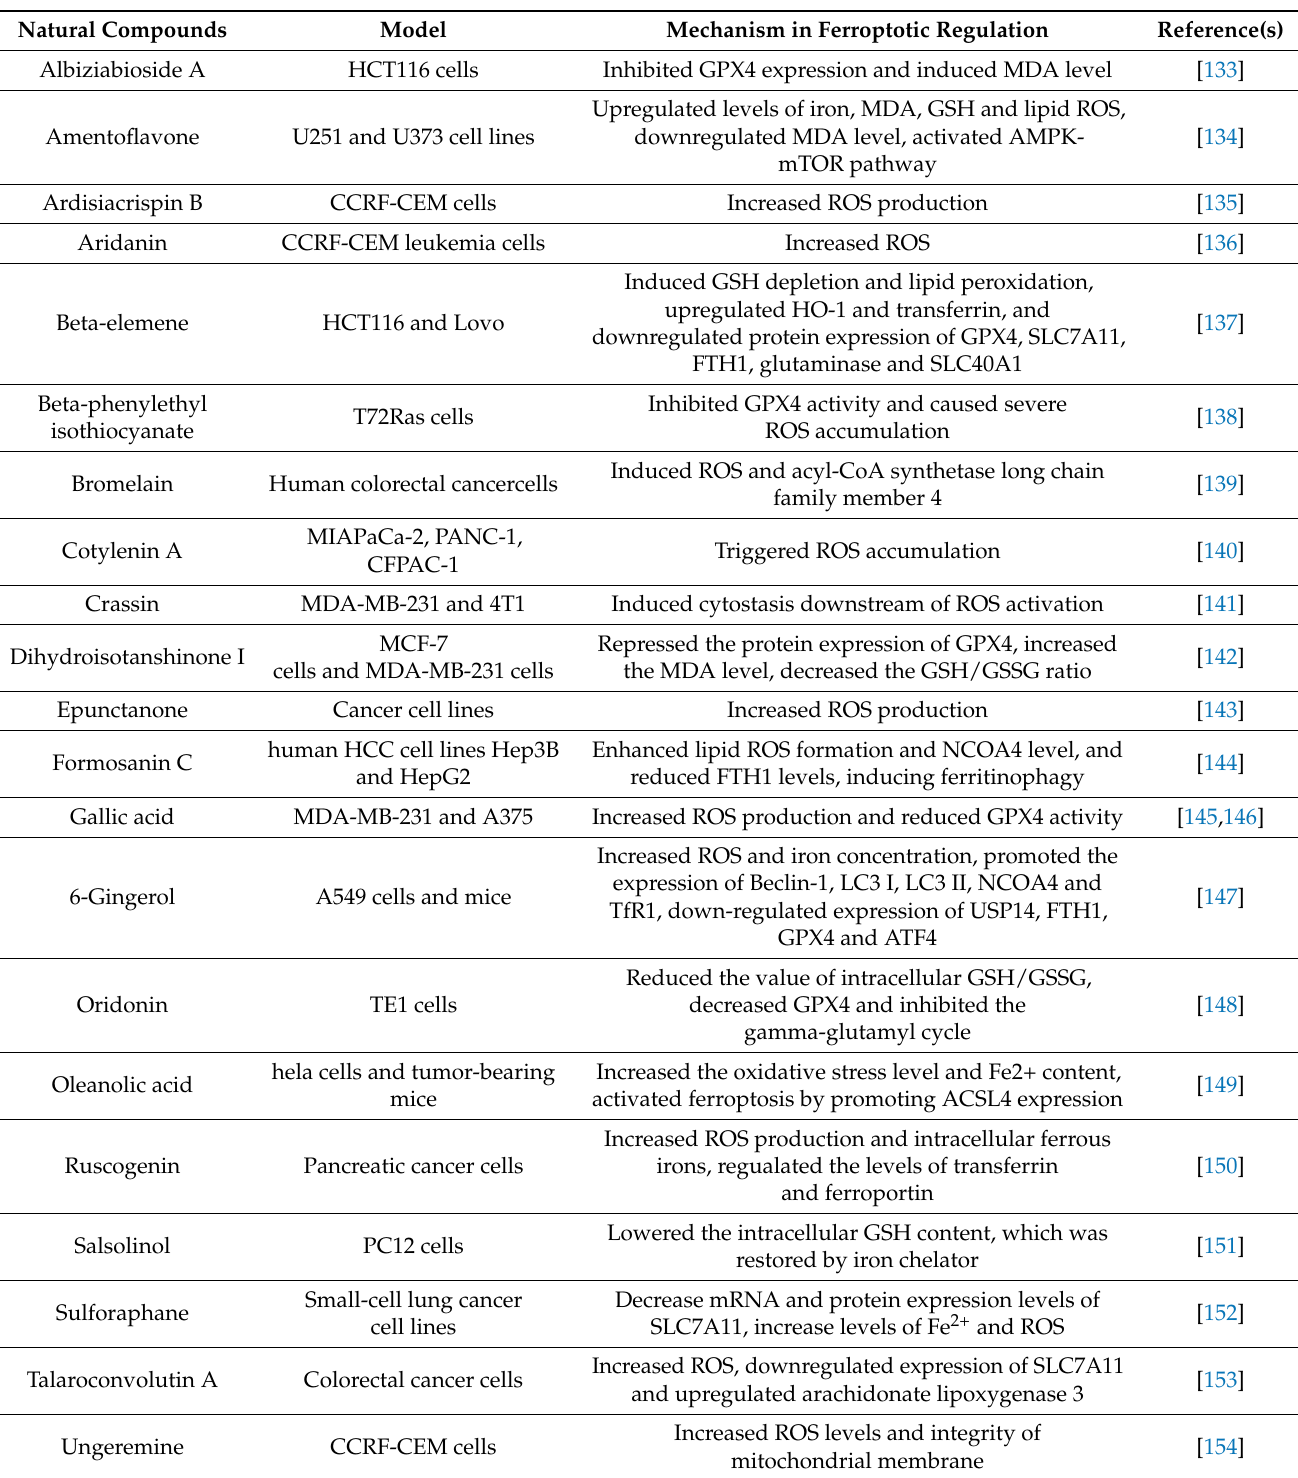
Table 2. The inductive effects and mechanisms of natural compounds on